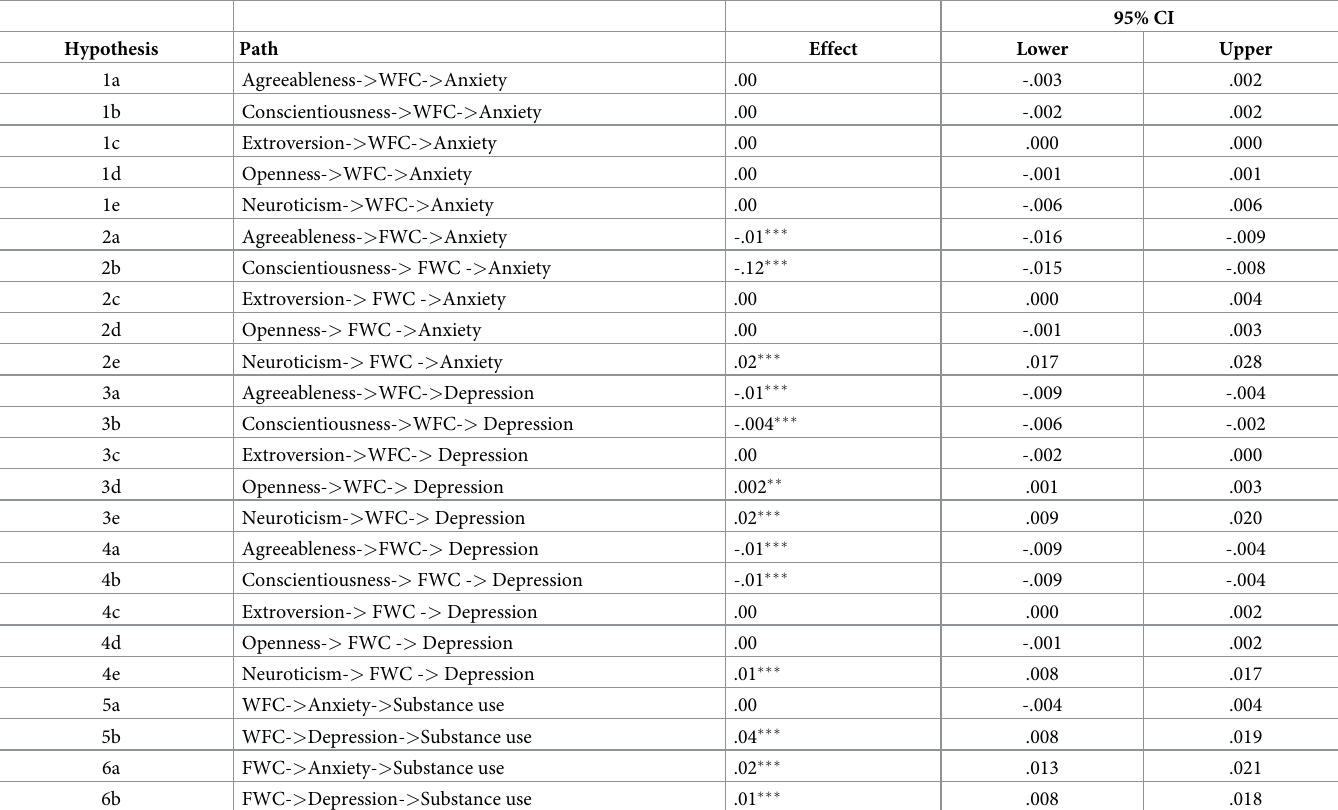
Table 3. Results for simple